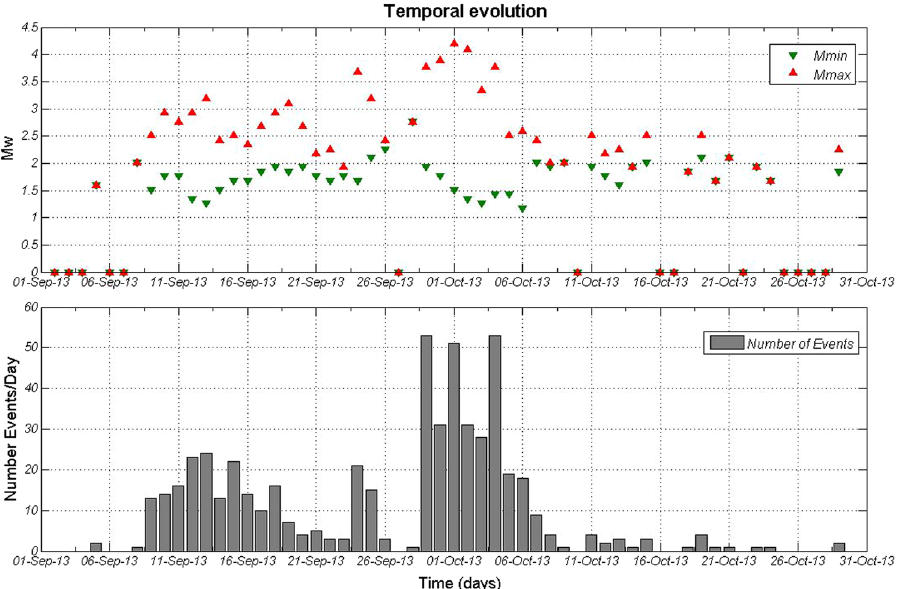
Figure 6. Temporal evolution of the sequence analyzed in this study. Red and green triangles correspond to the observed maximum magnitude and minimum magnitude per day, respectively and each gray bar represents the number of events per day.The figure was generated by using the ZMAP software.